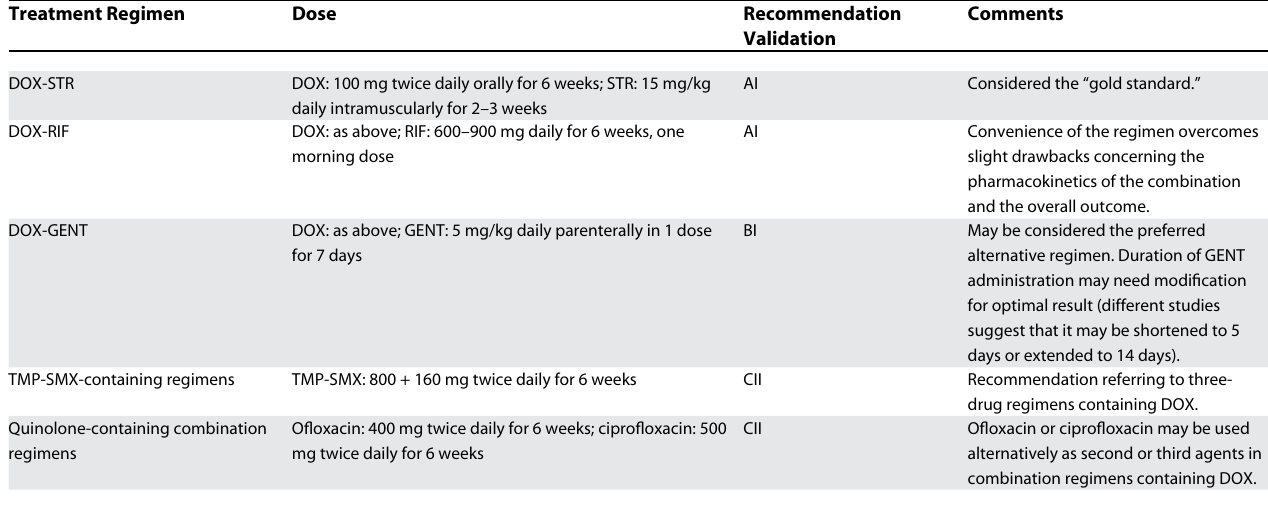
Table 2. The recommendations of Ioannina on the Optimal Treatment of Brucellosis Without Serious Complications in Adults Treatment Regimen